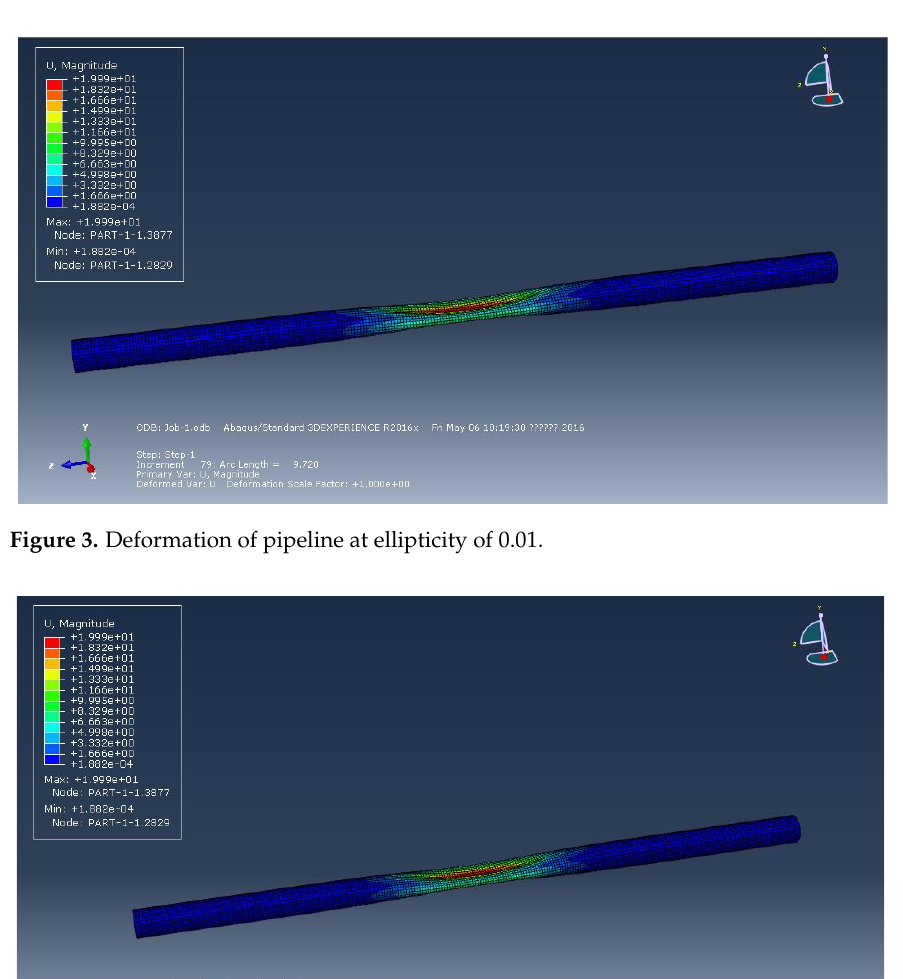
Figure 5. Pressure response curves of pipes with different ellipticity. Due to the initial imperfections in the pipeline, the critical pressure PI (also known as the initial pressure) is generally less than PC in Formula (7). Palmer and Martin [17] give the buckling propagation pressure of the pipe: 𝑃 𝑃𝑀 = 𝜋𝜎 𝑦 ( 𝑡 𝐷) 2 (16) According to the formula, the buckling propagation pressure is far less than the crit- ical pressure. In Figure 5, the pressure value of the gentle section on the right of the curve corresponds to the buckling propagation pressure. The combined value of the three pipes is approximately from 0.24 MPa to 0.25 MPa, which is significantly less than the critical pressure. Therefore, the pipe will propagate to both ends once local buckling occurs. The buckling propagation pressure is the control factor of the submarine pipeline design, which increases material and cost. The initial pressure represents the sudden springing stability of the pipeline and is extremely sensitive to defects, while the propagation pres- sure 𝑃 𝑃 is not sensitive to defects.